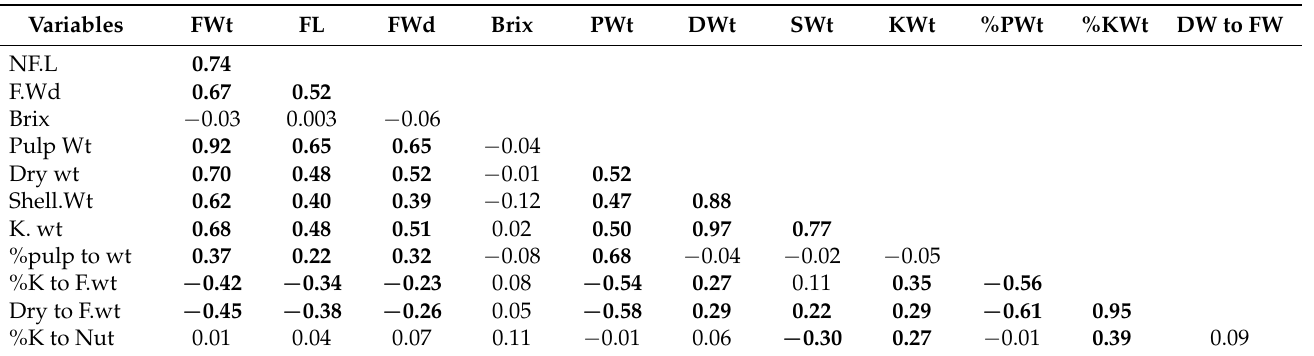
Table 5. Pairwise Pearson correlation coefficients of 12 quantitative variables evaluated on the 95 accessions from 9 locations.